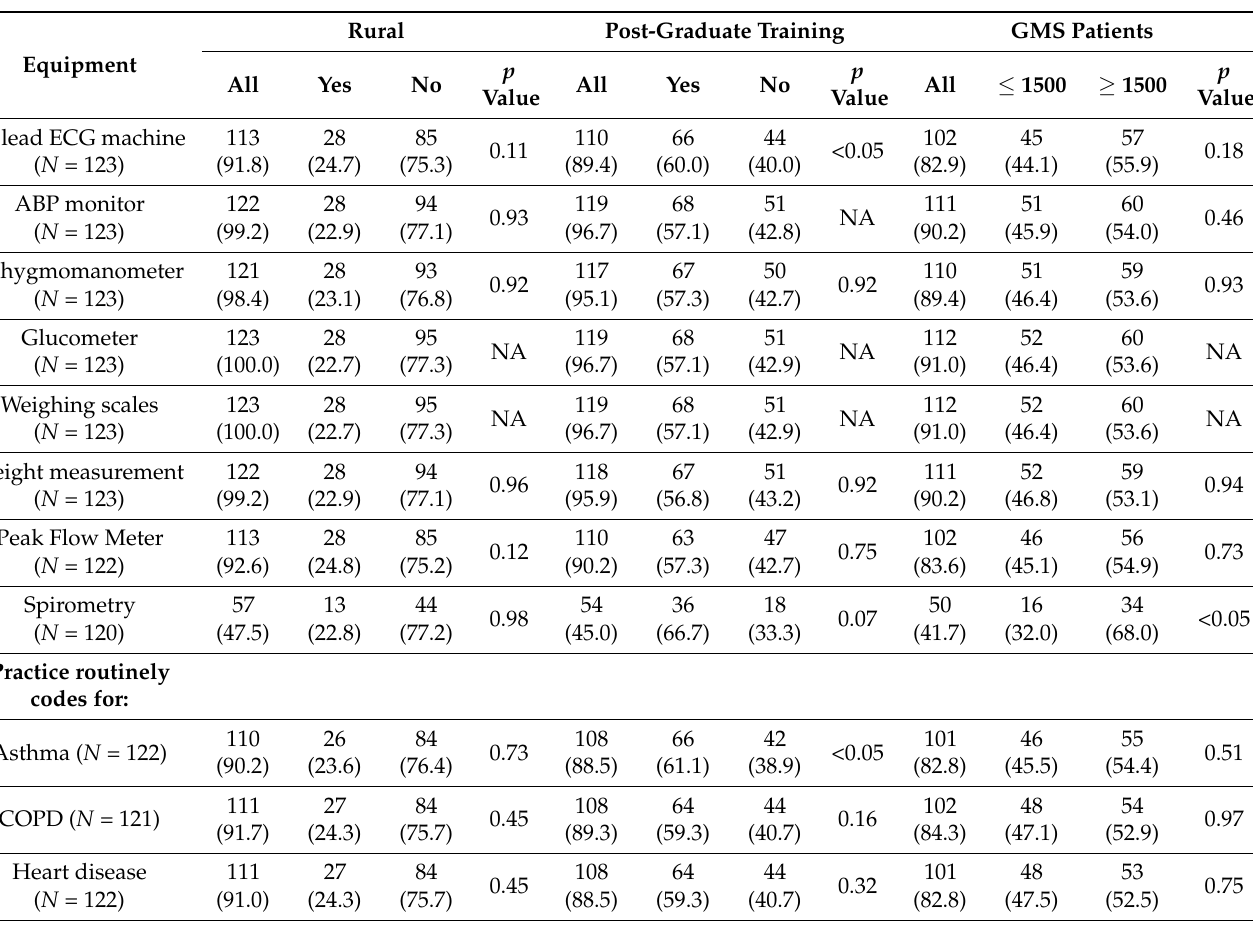
(Table 4). More than 90% of the practices routinely code for asthma, COPD, heart failure and diabetes, using their IT systems. Table 4. Equipment and disease coding within